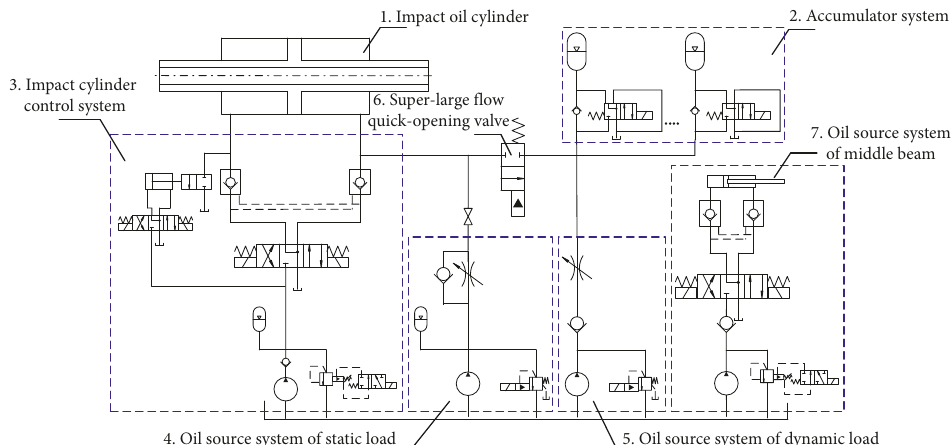
Figure 2: Principle diagram of hydraulic loading system.